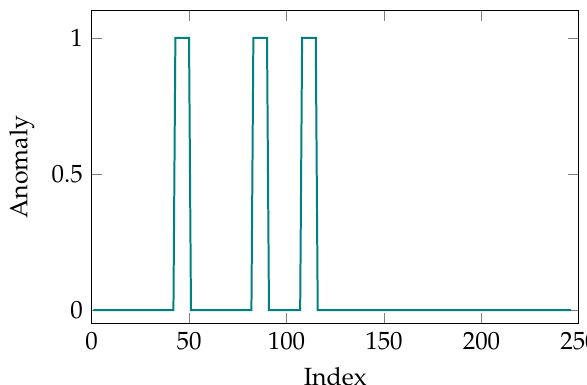
Figure 7. Indices of detected anomalies. Reconstruction errors above a given threshold are depicted as anomaly (1) and otherwise are set to normal (0).